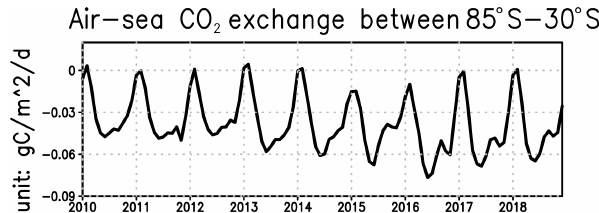
Figure B11. Monthly posterior air–sea CO 2 exchanges between 85–30 ◦ S. Unit: gC/m 2 /d.